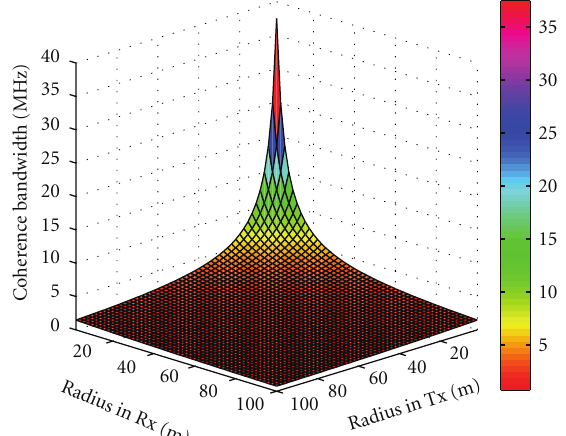
Figure 11: The minimum coherence bandwidth of 2 × 2 DP system varies with upper radii of spheres of Tx and Rx scatterers